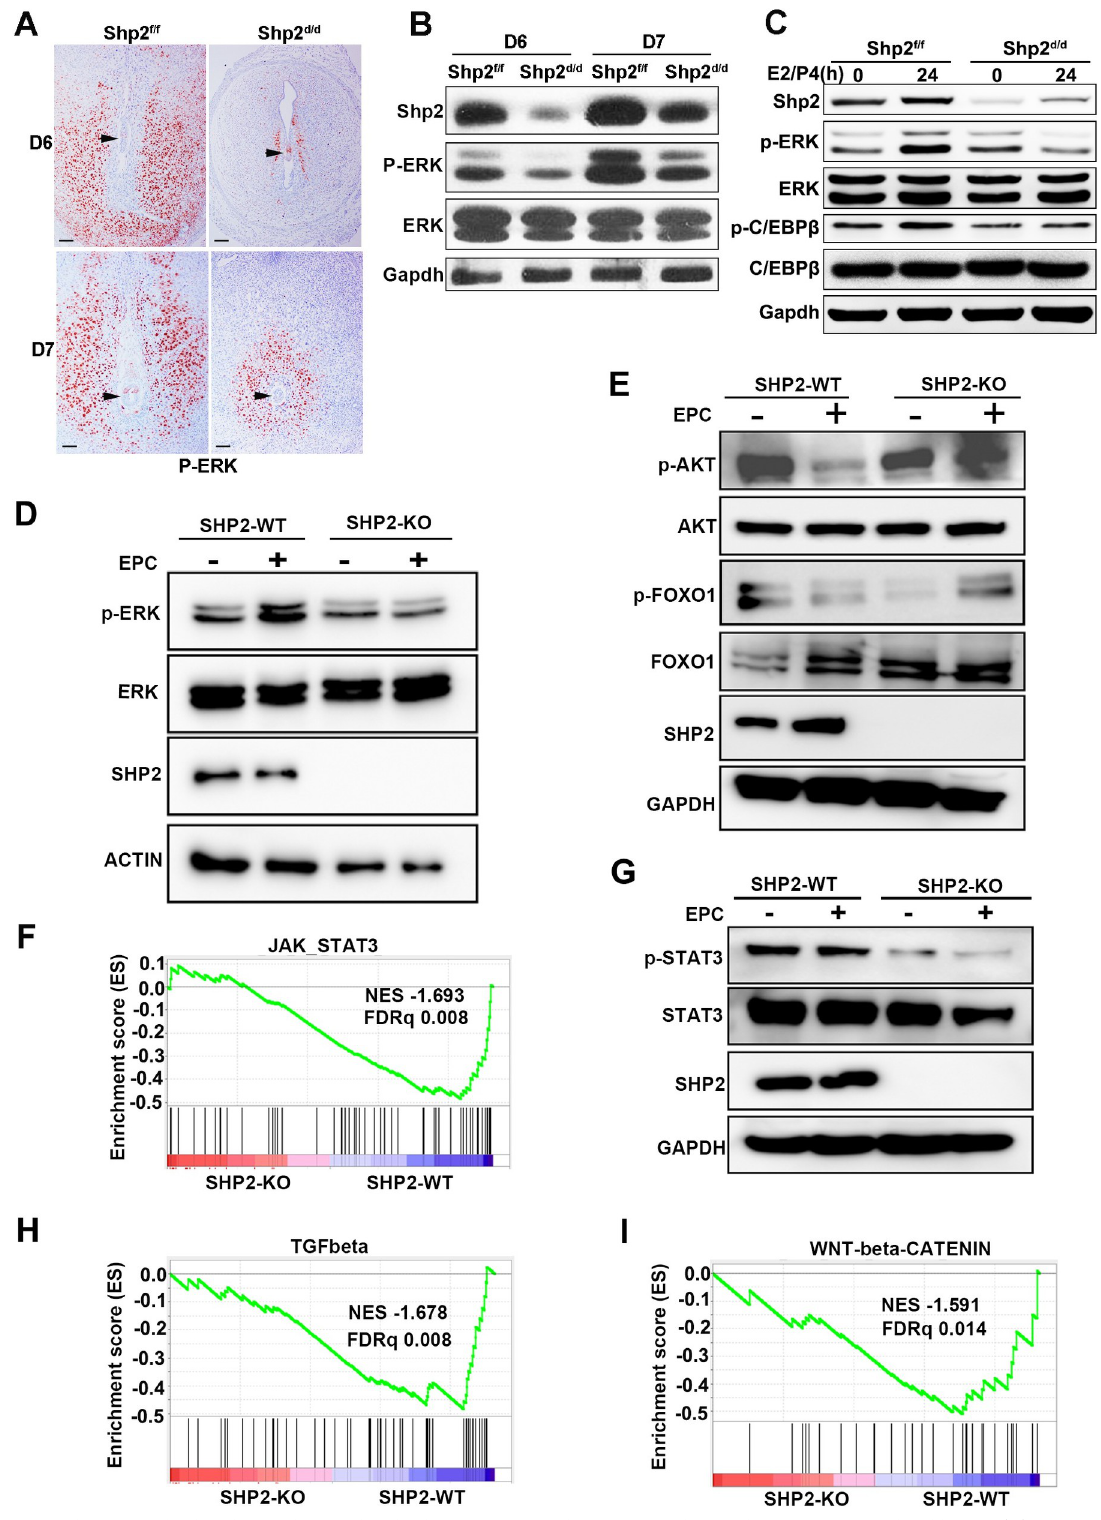
Fig 6. Shp2 is involved in the regulation of multiple ERK, AKT, and STAT3 signaling pathways in immortalized hESCs. (A) Immunohistochemical detection of phospho-ERK1/2 in the ISs of Shp2 f/f (n = 6) and Shp2 d/d mice (n = 6) on D6 and D7. The black arrowheads indicate the embryos. (B) The protein levels of Shp2, phospho-ERK1/2 and total ERK1/2 in the ISs of Shp2 f/f and Shp2